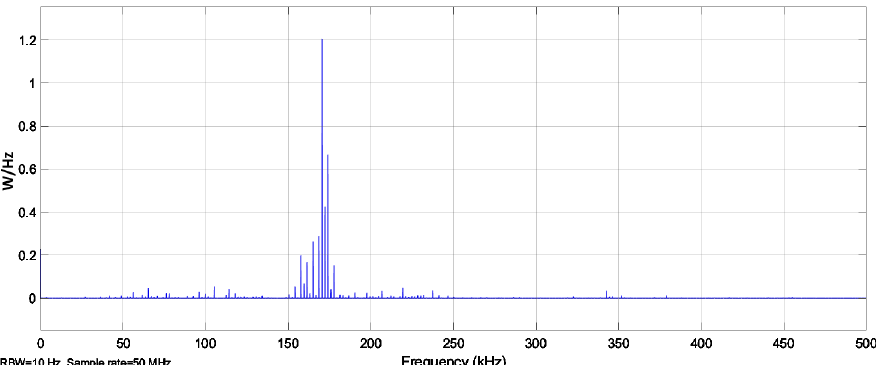
Figure 3. The spectrum of the chaos generator output signal.